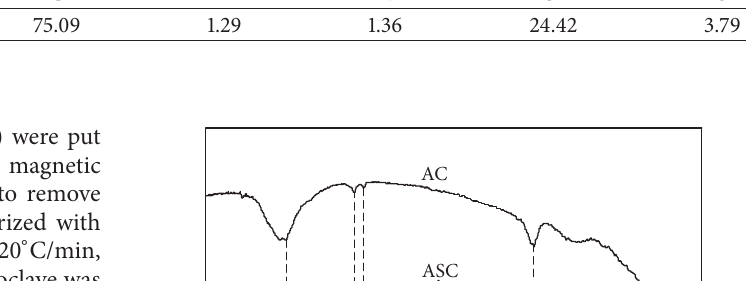
were 0.26 cm 3 /g, 2.66 nm, and 526.3 m 2 /g, respectively.